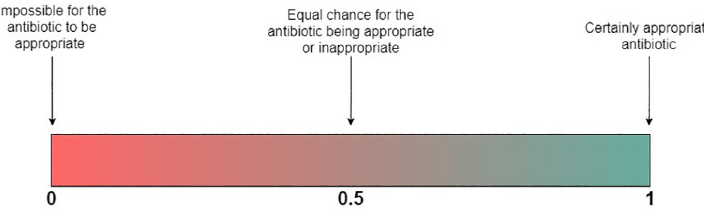
Fig 2. Description of WISCA properties. WISCA is a probability for an antibiotic to be appropriate for a certain infectious disease. Probabilities lie between 0 to 1. Therefore, if an antibiotic has a probability of 1 it is certain to cover all possible causative pathogens whilst these pathogens are all sensitive towards the antibiotic. This information is derived from surveillance of a population and therefore it cannot make inference to the possible effectiveness for an individual, which requires consideration of pharmacokinetic variables.